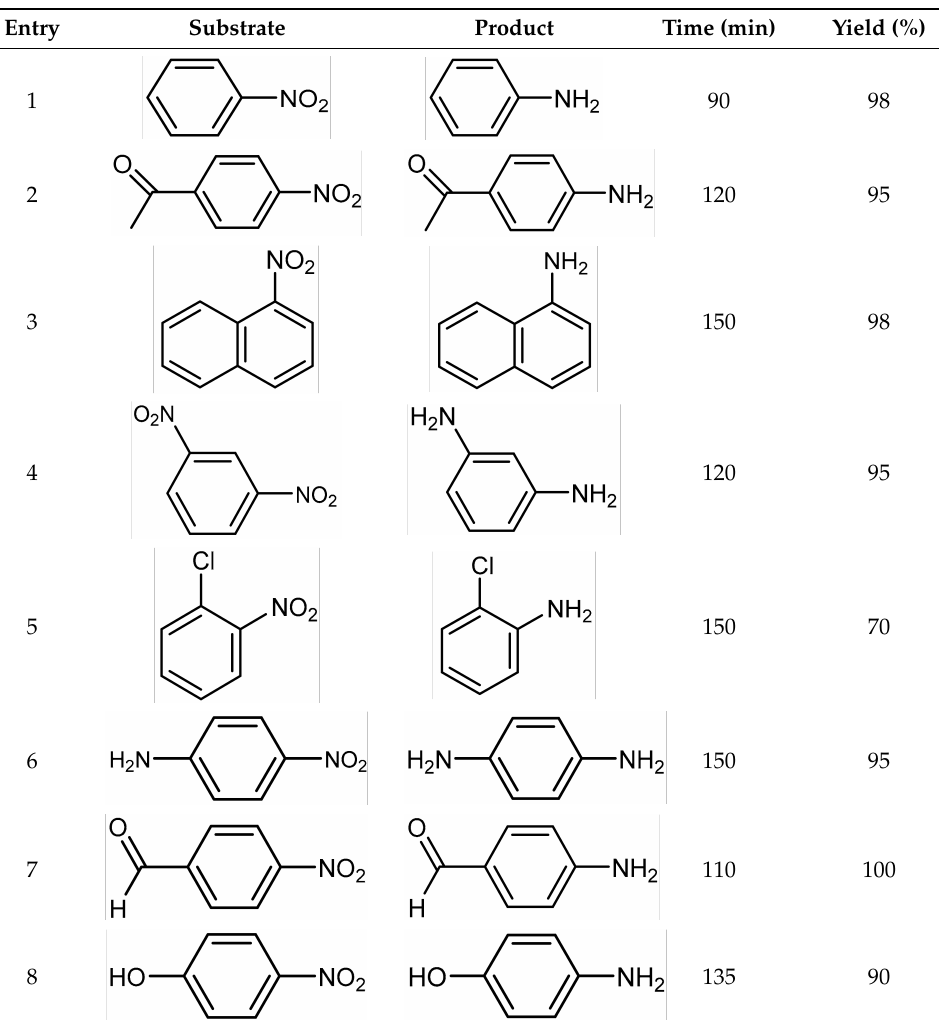
Table 2. Hydrogenation of various nitroarenes under Pd@Per-P